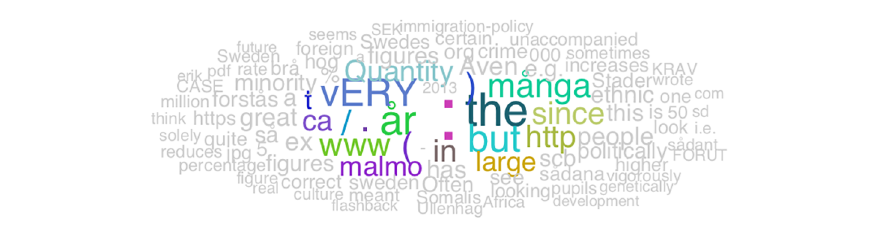
Figure 1c. Word cloud showing significant positive (indicative of late usage of the words) correlations respectively, between word frequency and time of writing on the forum for individual users (i.e., the logarithm of the number of days plus one since an individual user makes the first post on the forum). Colored words are significant following Bonferroni correction for multiple comparisons, and grey words are significant at p < .05. Font size is proportional to the relative correlation.